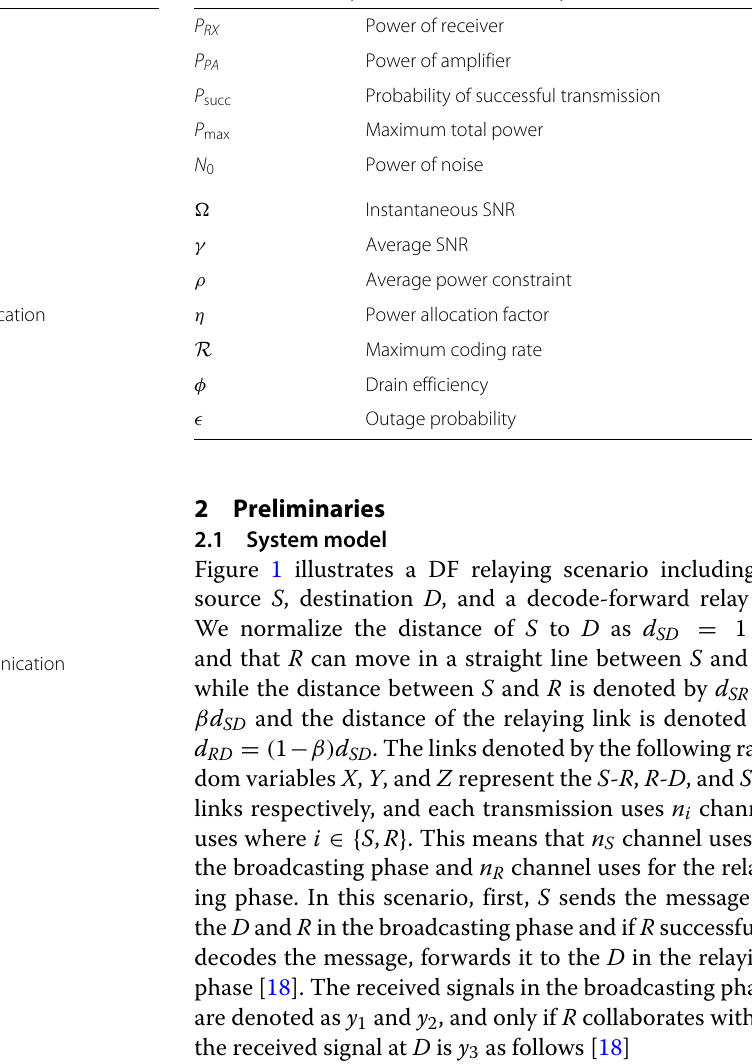
Table 1 Summary of the functions and symbols ( Continued